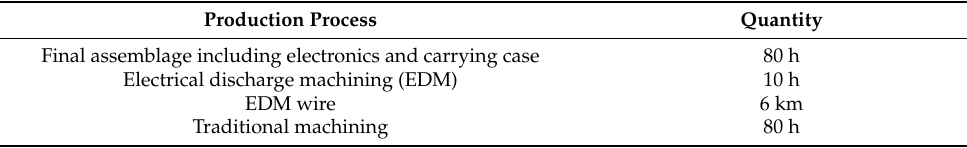
Table A2. List of other resources needed to construct one pair of